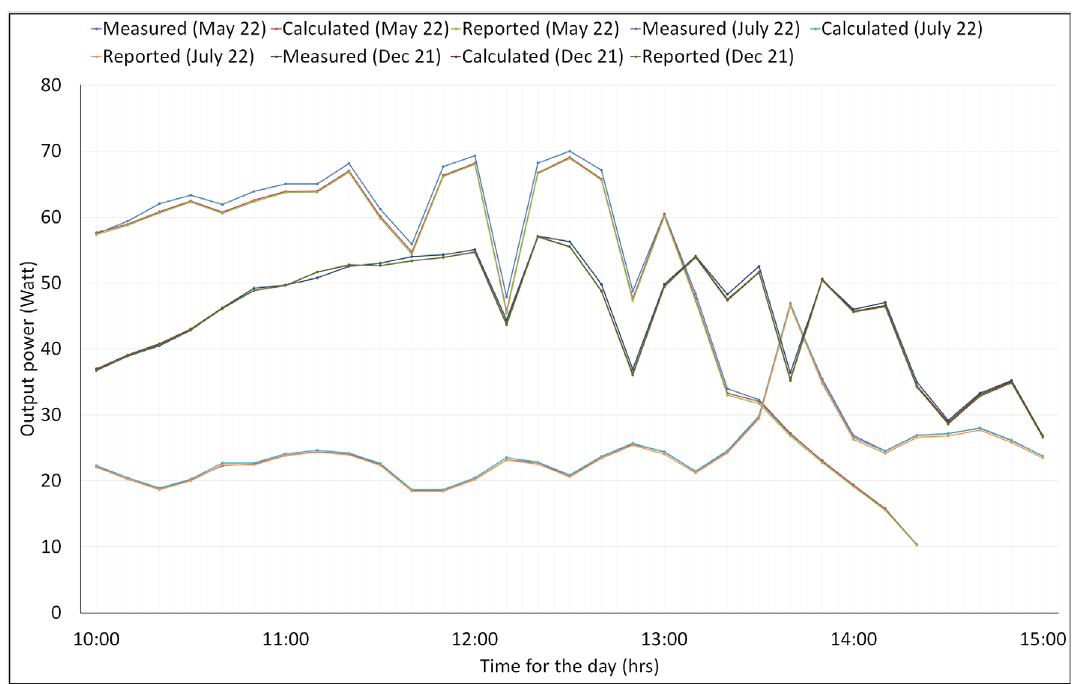
Table 2: Calculated photovoltaic module e ffi ciency for a-Si / thin film technology module.